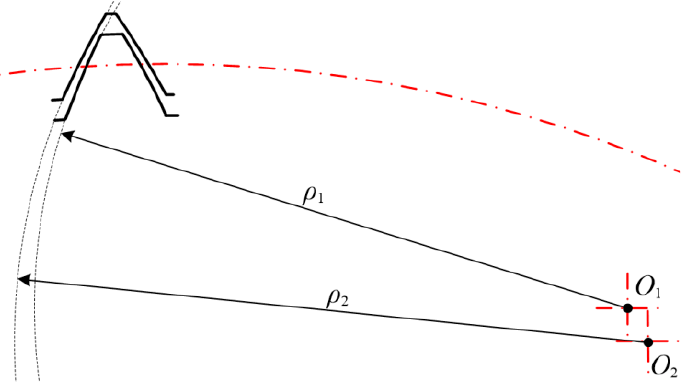
Figure 10. The Hertz contact model of involute harmonic gears. The involute profile teeth are shown in Figure 11, and the comprehensive curvature radius in the meshing area of the disposable harmonic gear is shown in Figure 12.